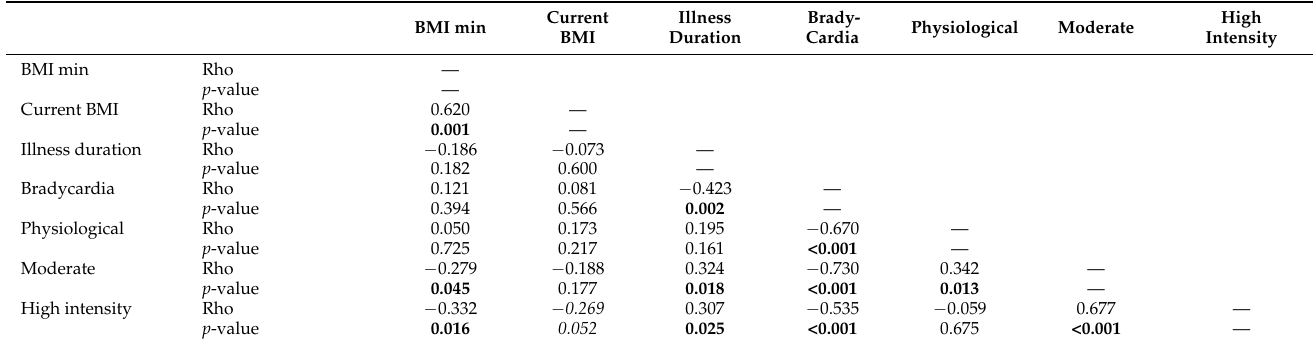
Table 5. Non parametric correlation for BMI minimum, current BMI, illness duration and heart rate ranges in acute AN patients ( n = 55). Significant p -values are in bold. Trend values are in italics. BMI: body mass index; EDI: Eating Disorder Inventory II; HADS: Hospital Anxiety and Depression scale; YBS: Yale Brown Scale.